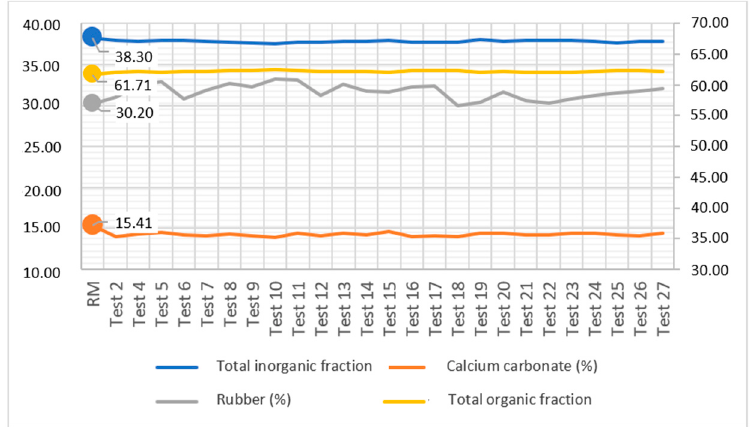
Figure 6. Composition of original RM and original devulcanized samples.